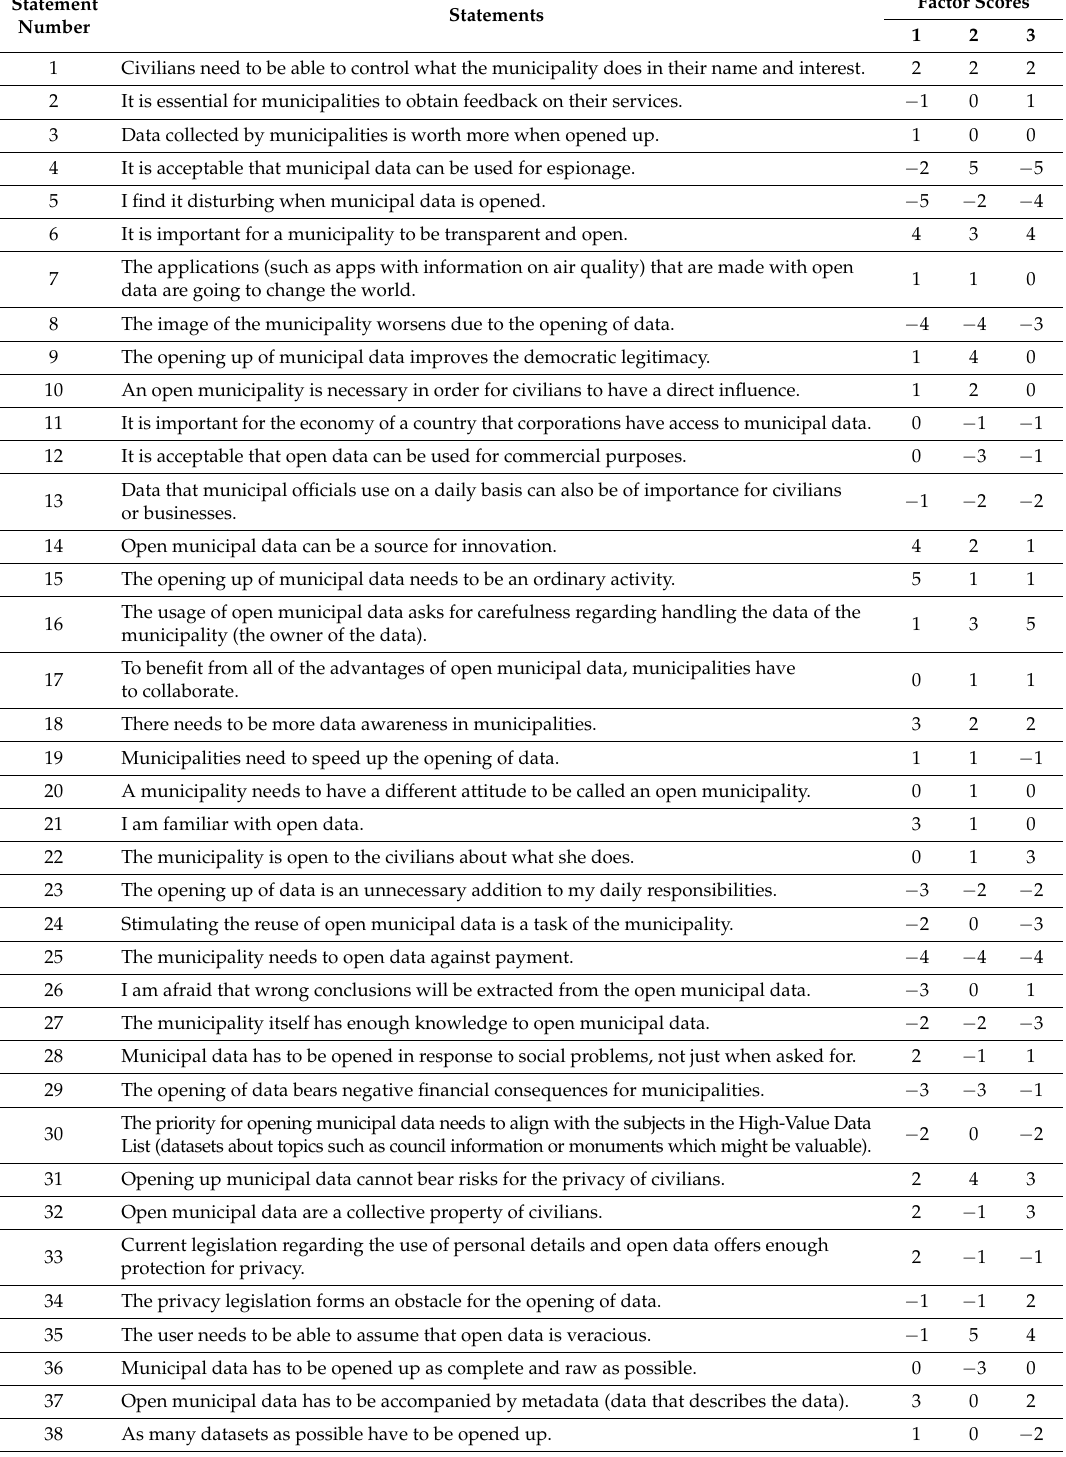
Table 2. Factor scores of the three extracted